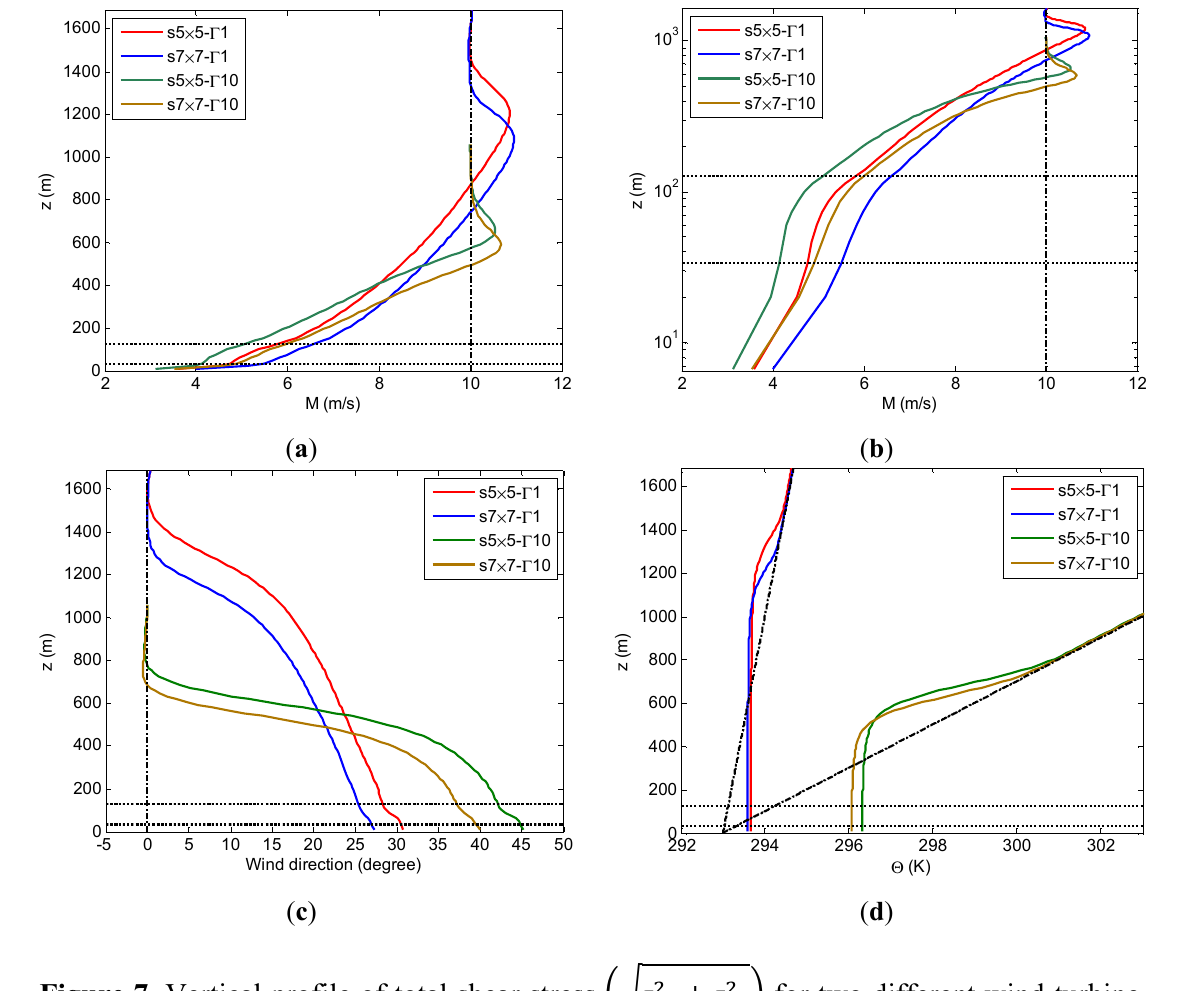
Figure 6. Vertical profiles of horizontally-averaged velocity magnitude M in ( a ) linear scale; and ( b ) semi-log scale; ( c ) wind direction; and ( d ) horizontally-averaged potential temperature ( Θ ) through very large wind farms for two different wind-turbine spacings, and two different values of Γ .